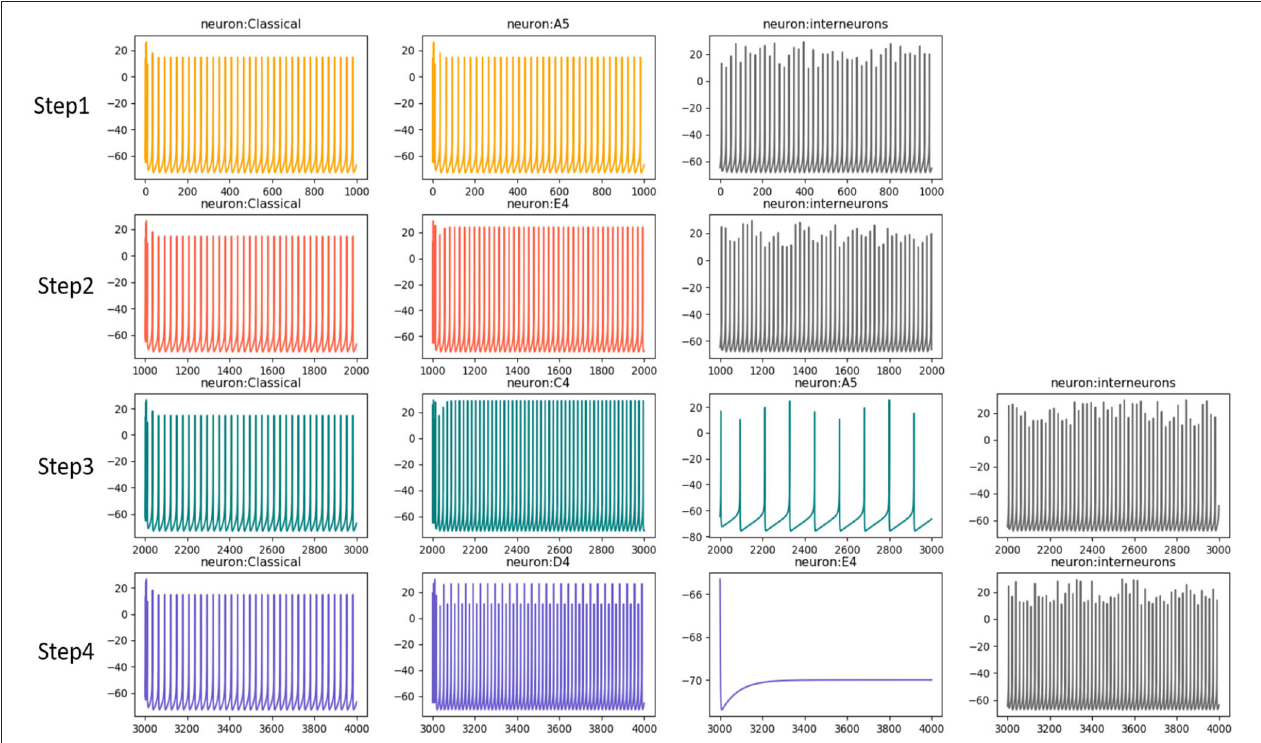
FIGURE 8 | The neural oscillation during composition process. The neurons fire with gamma waves, however, the neurons a 5 and e 4 have slow or no activities since they fail in